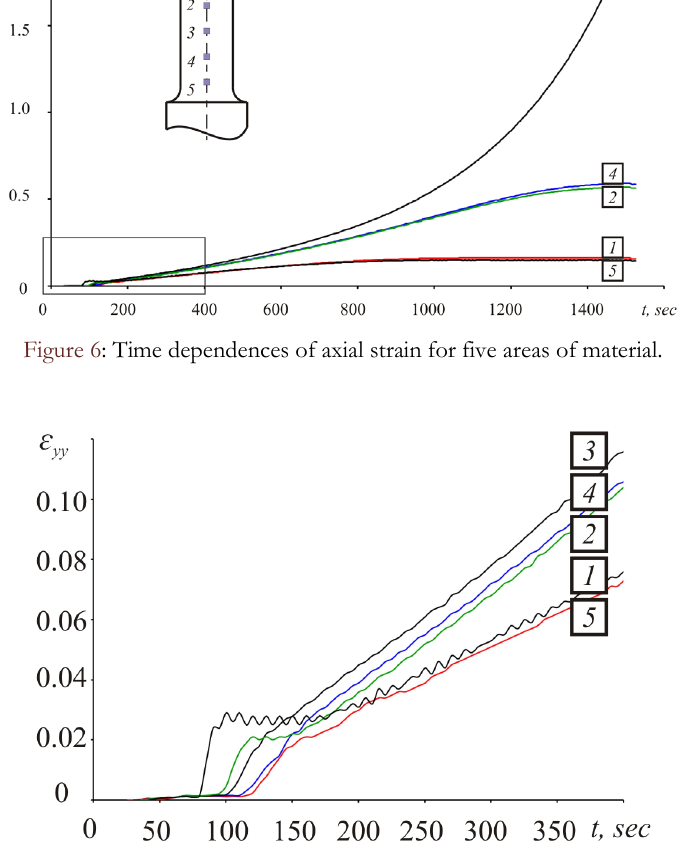
Figure 7: Time dependences of axial strain at the stage of yield plateau forming and at the material hardening